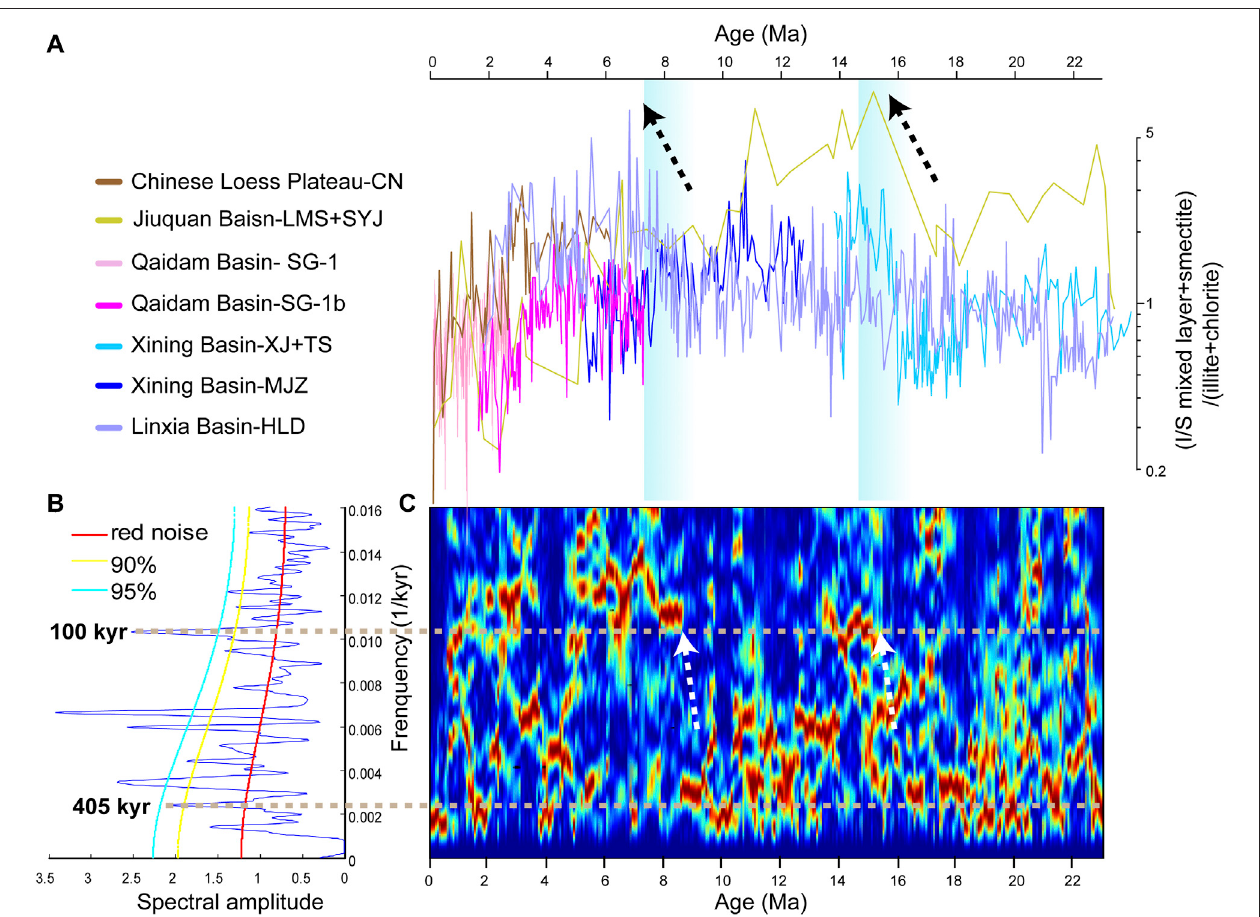
FIGURE 4 | Orbital-scale variability of silicate weathering intensity since 23 Ma (A) Compiled (I/S mixed layer + smectite)/(illite + chlorite) ratio since 23 Ma (B) 2 π - Multi-taper method (MTM) power spectrum of the (I/S mixed layer + smectite)/(illite + chlorite) ratio, and (C) evolutive Fast Fourier transform spectrum used a 400-kyr sliding window, with a robust red-noise model at the 95% con fi dence level. The bold white arrows in (C) show an intensi fi ed eccentricity 100-kyr cycle at ~16 Ma and ~8 Ma.